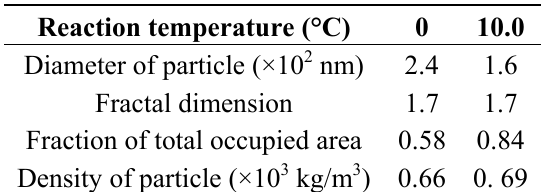
Table 2. Reaction temperature dependence of the structural parameters of the